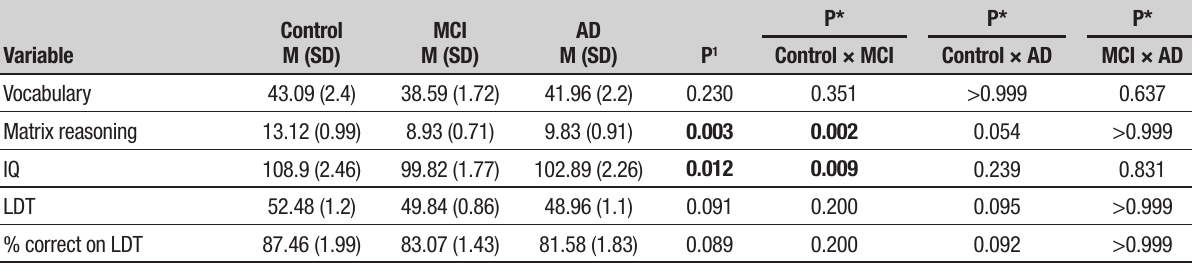
Table 3. Description of neuropsychological tests and IQ with estimated mean values and standard errors and LDT, adjusted for sociodemographic char- acteristics and result of comparisons, by group. Variable